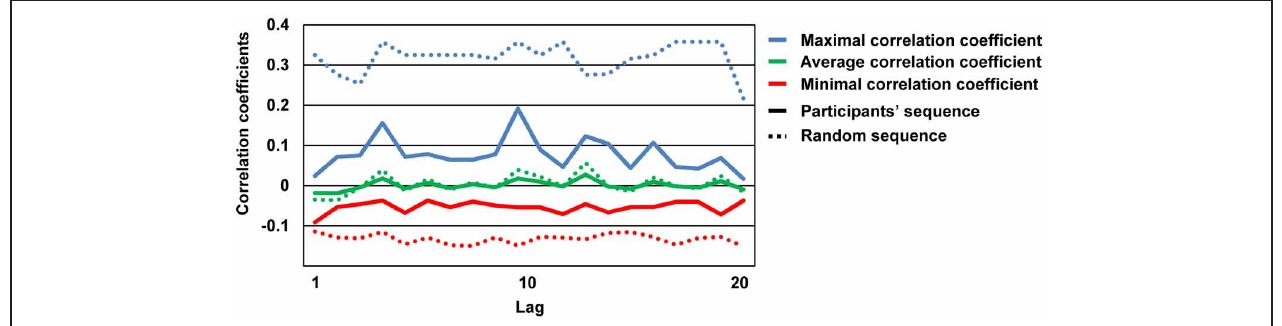
lines). The sequences of FA from the participant did not differ statistically from the random sequences (see the Results section), supporting that random fluctuations in the pre-stimulus period may account for FA